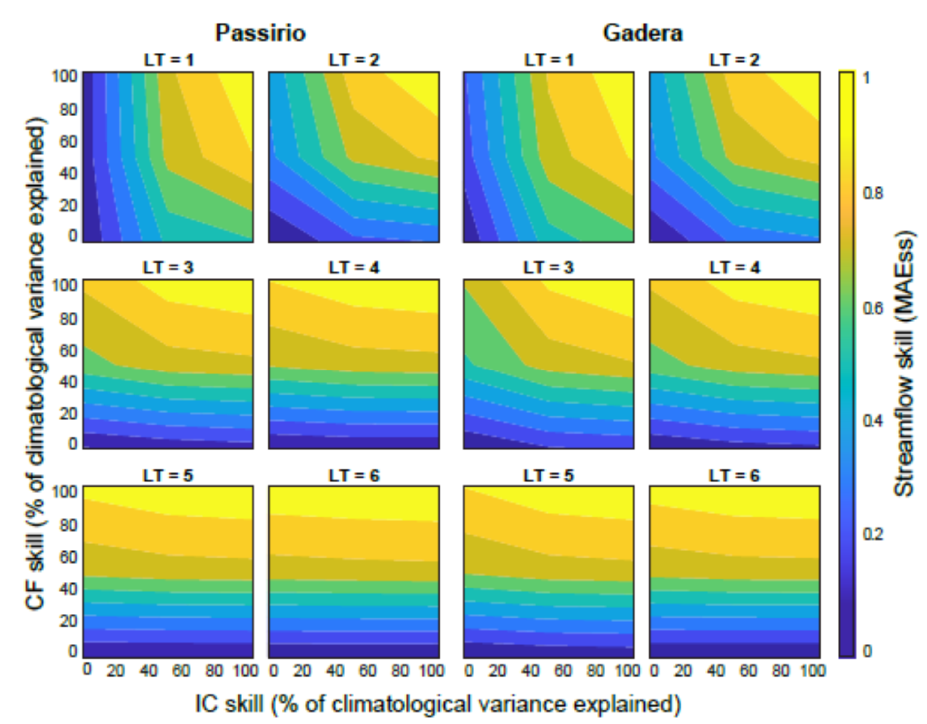
Figure 7. As in Figure 6 but for forecast initialization on 1 March.